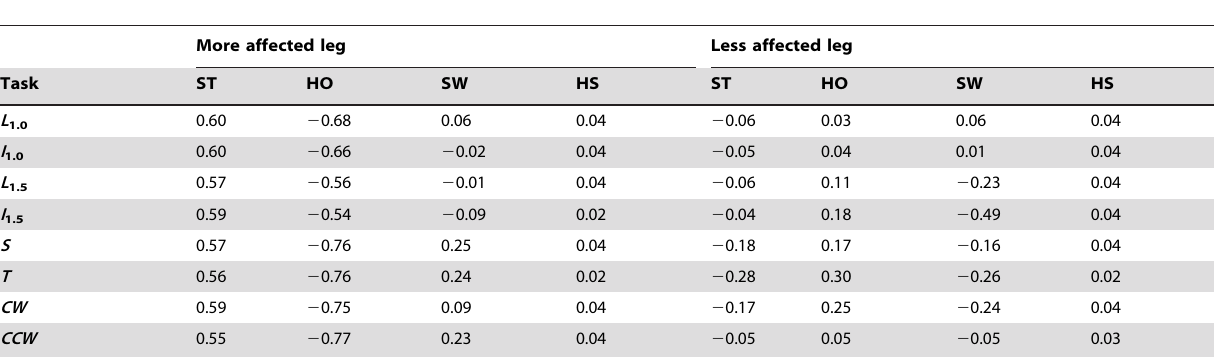
Table 3. Correlation coefficients between GMFM and time spent in each gait phase by children with hemiplegia as determined by A OL .